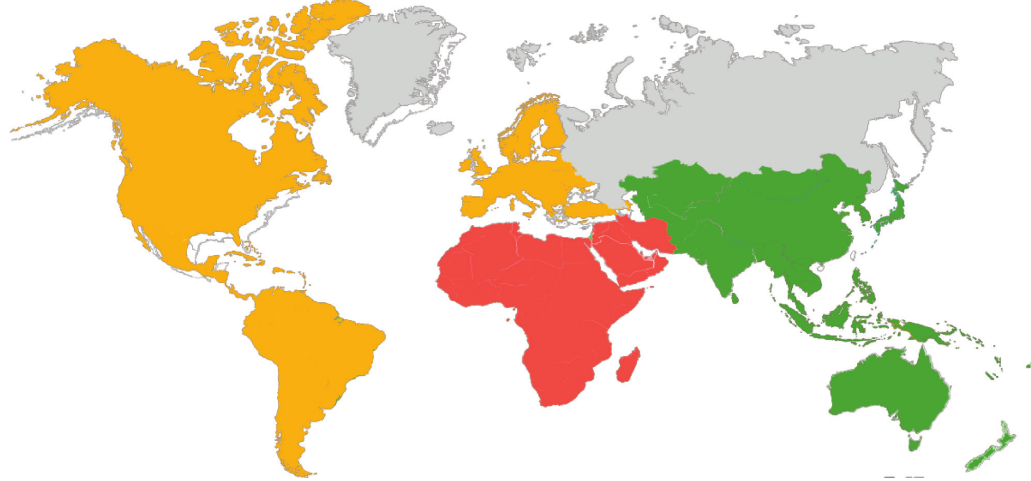
Figure 2: Artificial intelligence in the food and beverage